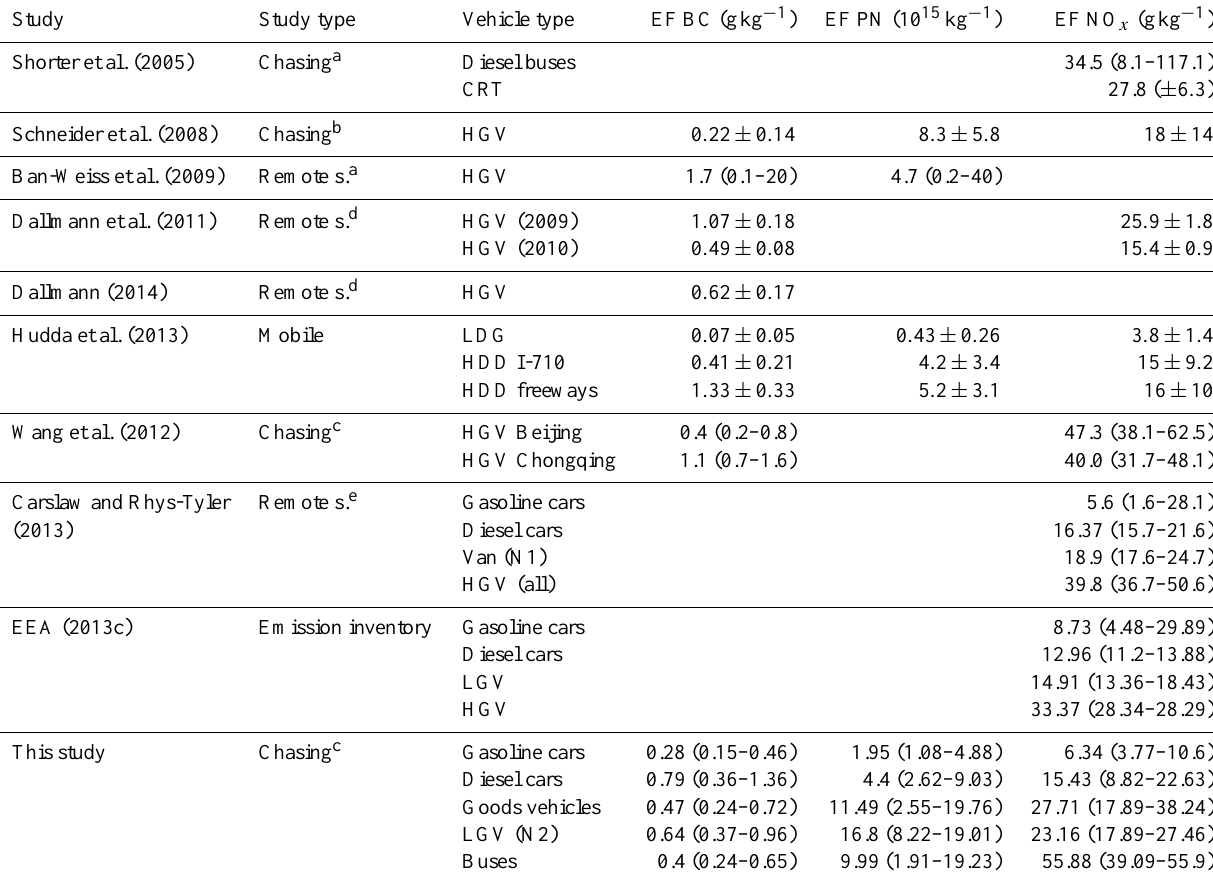
Table 7. Comparison of EF with other similar on-road